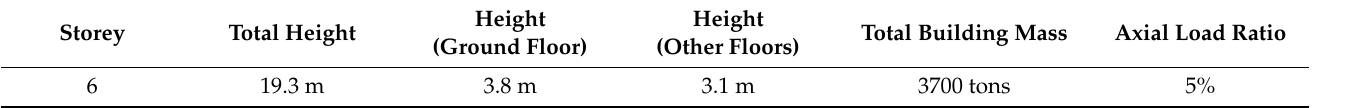
Table 5. Parameters of the case study